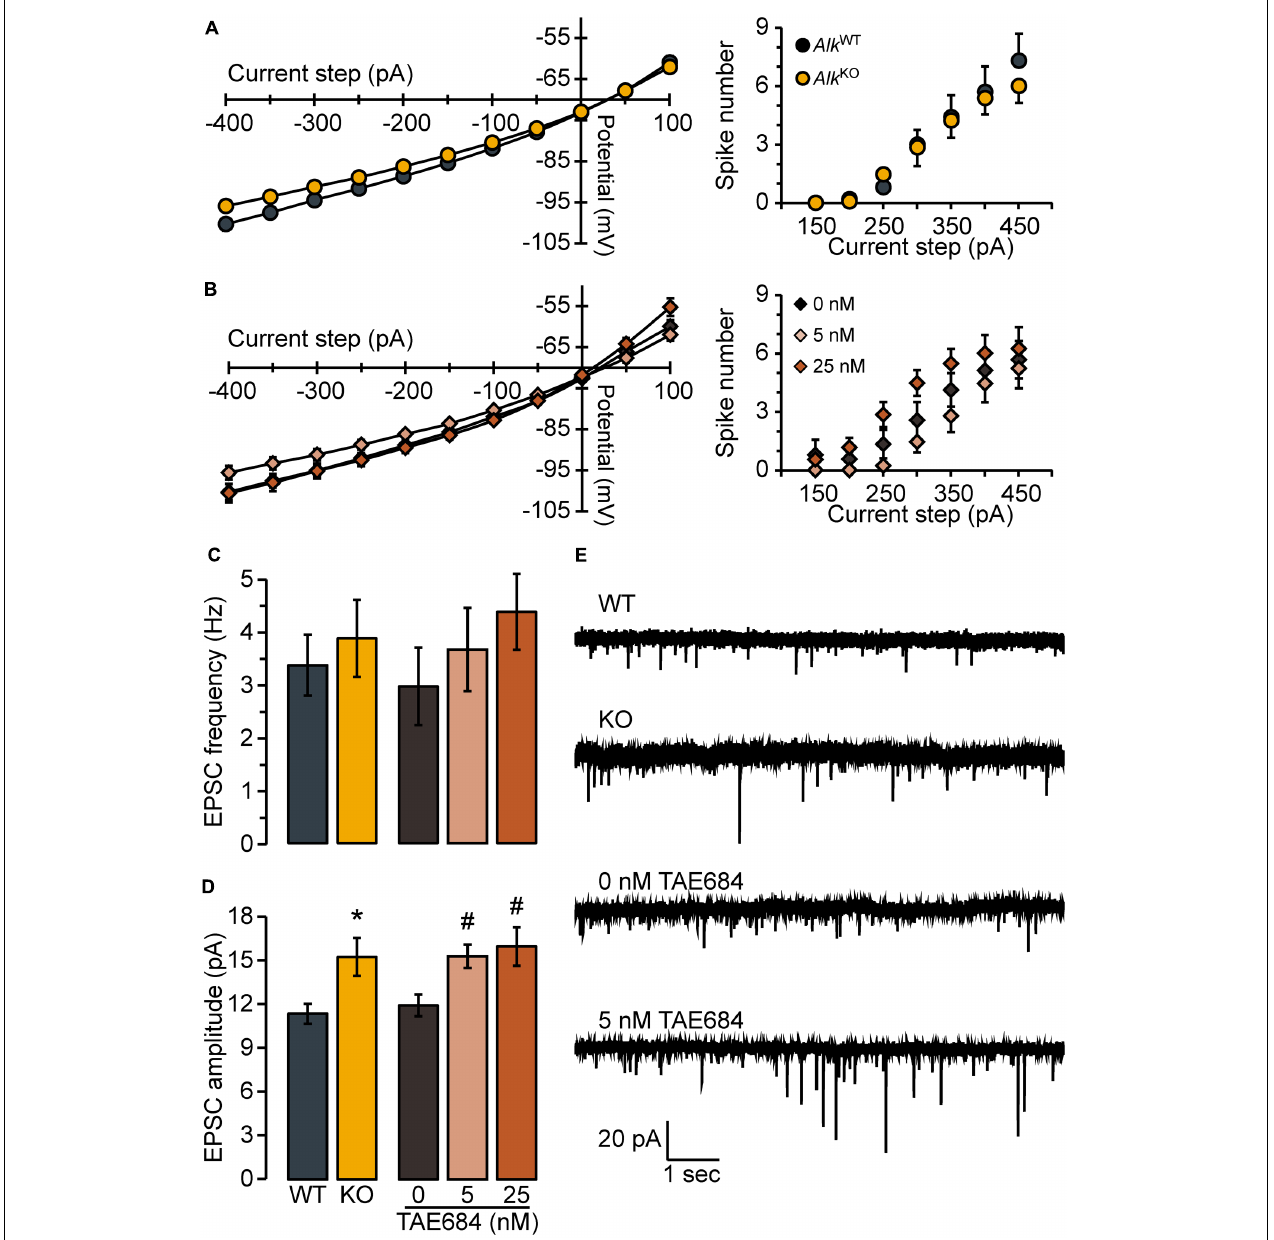
FIGURE 2 | Loss of ALK does not alter membrane properties or excitability but promotes excitatory synaptic transmission. Membrane voltage (left) and spike firing (right) responses to hyperpolarizing and depolarizing current steps (300 ms duration) for Alk KO vs. Alk WT (A) or TAE684 (5 and 25 nM) vs. vehicle (0 nM) (B) . Frequency (C) and amplitude (D) of spontaneous EPSCs in Alk WT and Alk KO , and in vehicle-treated (0 nM) and TAE684-treated (5 and 25 nM). ∗ p = 0.02, Alk KO vs. Alk WT . # p = 0.02, 5 nM vs. 0 nM, and p = 0.04, 25 nM vs. 0 nM (Games-Howell post hoc comparisons). (A–D) Data are represented as group means ( ± SEM) for Alk WT ( n = 10 cells, four mice), Alk KO ( n = 13 cells, five mice), vehicle-treated ( n = 8 cells, five mice), 5 nM TAE684 ( n = 9 cells, five mice), and 25 nM TAE684 ( n = 14 cells, six mice). (E) Representative current traces showing NAcSh D1MSN spontaneous EPSCs.